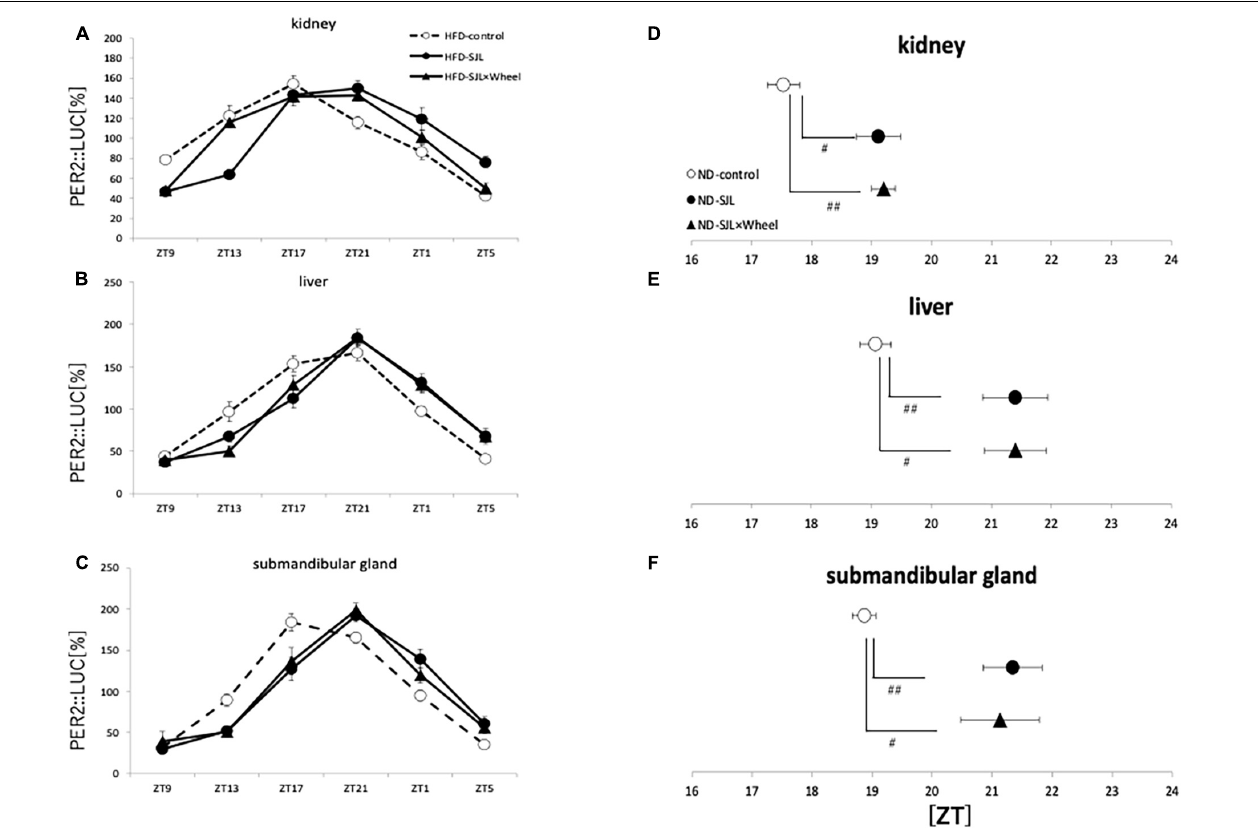
FIGURE 3 | Wave form and acrophase of PER2:LUC expression rhythm in each organ in LD or SJL conditions during ND feeding. (A–C) Waveforms for each group in kidney, liver, and submandibular gland. The group raised under normal LD conditions was designated as the control. (D–F) Acrophase for each group in kidney, liver, and submandibular gland. Data are presented as mean ± standard error of the mean (ND-control, n = 6; ND-SJL, n = 7; ND-SJL × Wheel, n = 6). # p < 0.05, ## p < 0.01 (Kruskal-Wallis test with Dunn’s multiple comparisons